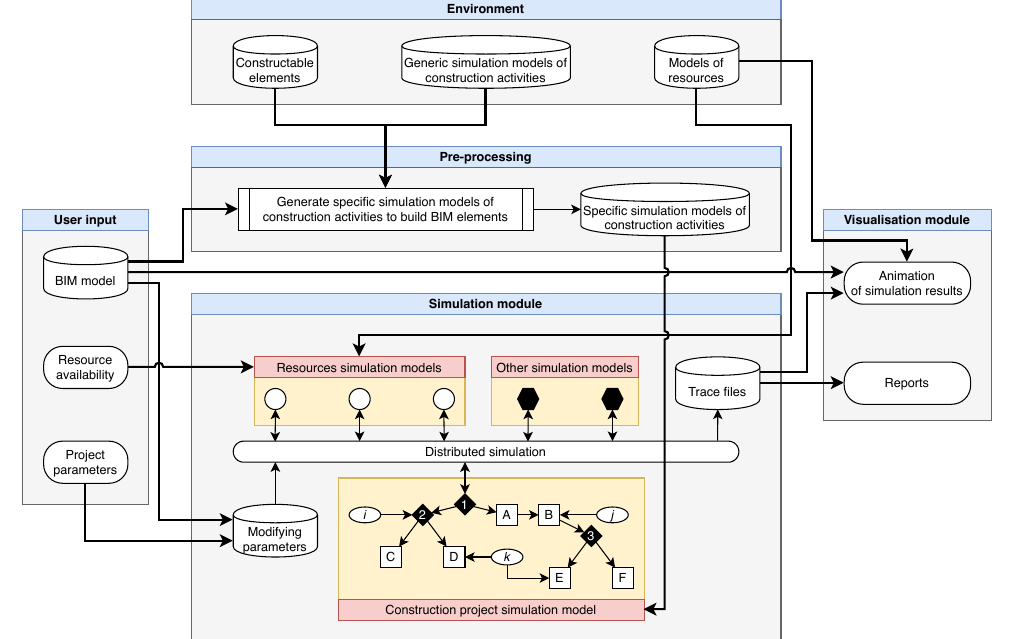
Figure 3. Overview of the proposed